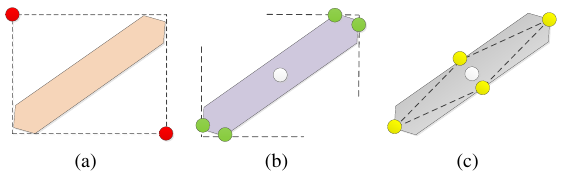
Figure 2. Three different keypoint definition strategies. (a) Two keypoints are located at the top-left corner and the bottom-right corner of the bounding box of an object. (b) Four extreme points are selected as the keypoints. (c) We define five keypoints: the center point and four other points located at the head, the tail, the midpoint of the left side and the midpint of the right side,